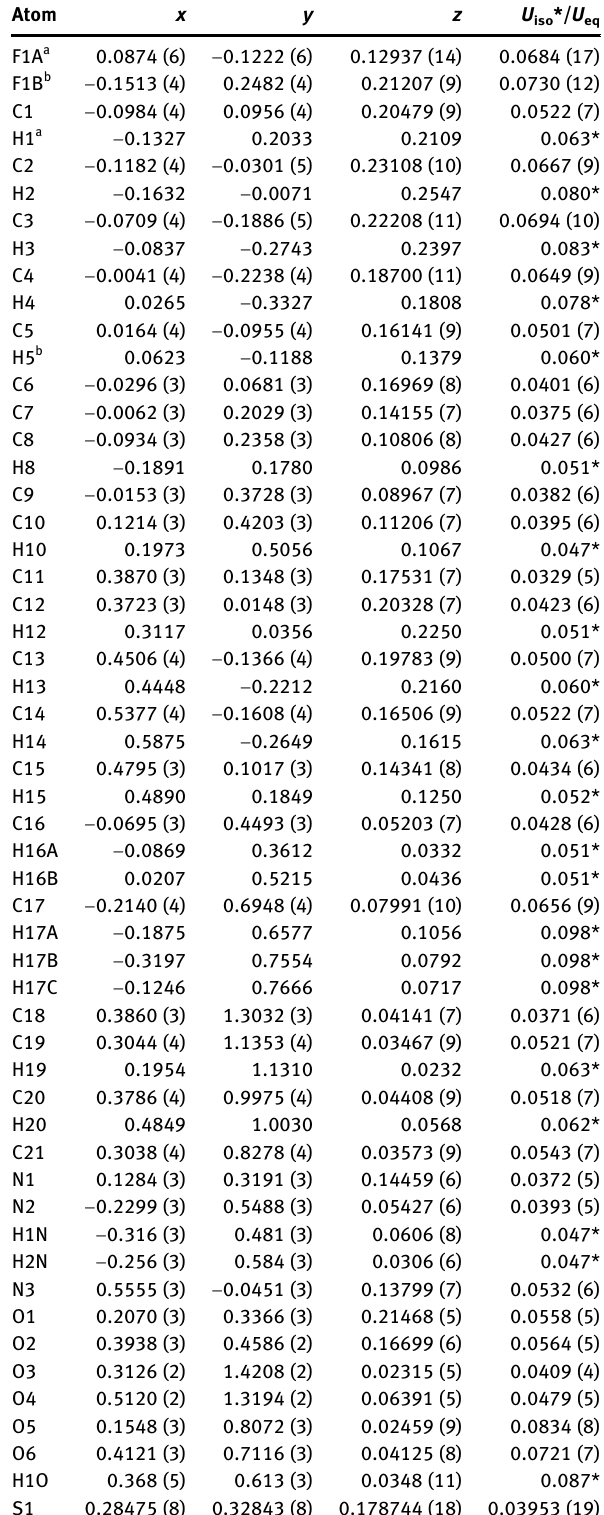
Table  : Fractional atomic coordinates and isotropic or equivalent isotropic displacement parameters (Å 